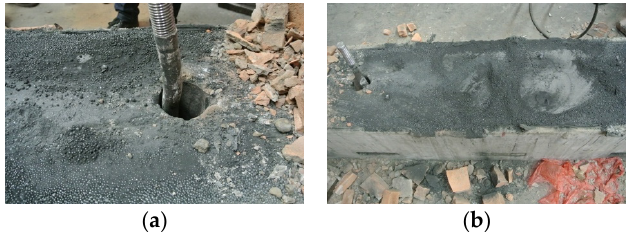
Figure 14. MG slide and restrictive rebars upon failure of wall ( a ) buckled restrictive rebars; ( b ) MG slide upon failure of wall.